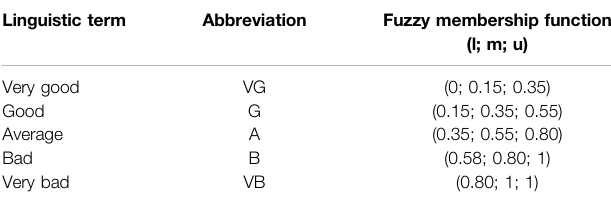
TABLE 3 | Linguistic evaluation and triangular fuzzy number for de fi ning fuzzy sustainability indicators in the CHP system assessment Linguistic term